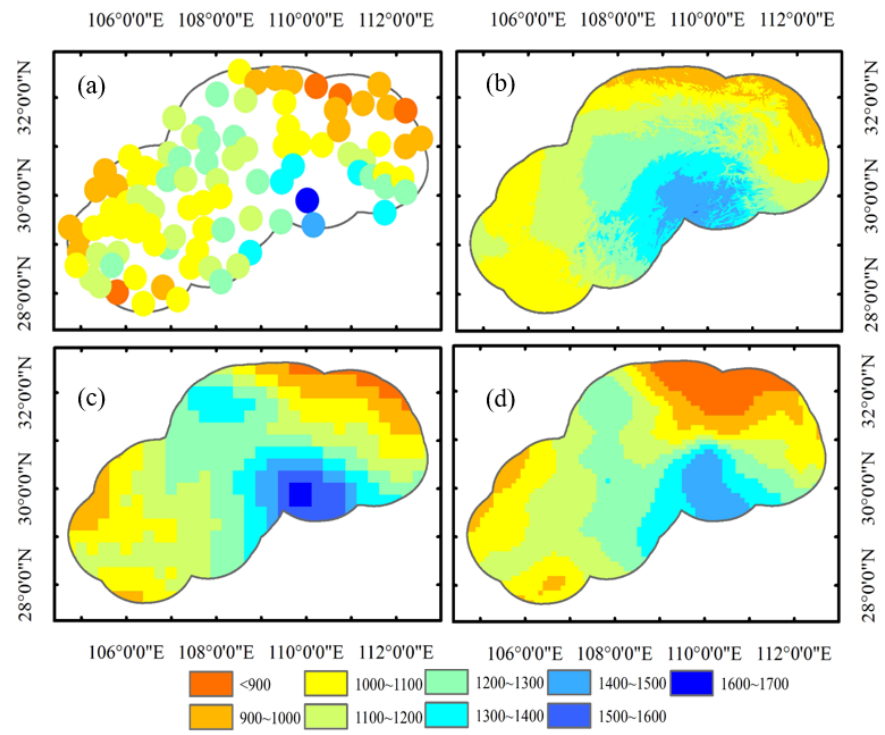
Figure A2. Spatial distribution of annual mean precipitation over 1988–2017 from ( a ) station obser- vations, ( b ) Peng et al. (2019) dataset, ( c ) CN05.1, and ( d ) CMFD (unit: mm/yr). In addition, we also used the three-cornered hat (TCH) method to evaluate the three datasets. Compared with the traditional error estimation methods, the TCH method can evaluate the accuracy of three or more different datasets when the true reference field is unknown [55,56]. In addition, this method is insensitive to the systematic biases and error cross-correlations contained within the datasets. The TCH method can be used to evaluate the uncertainty of multiple precipitation products in an iterative optimization process [57]. The RMSE values of CN05.1, CMFD and 1-km monthly precipitation dataset for China were obtained by the TCH method in the TGRA, which are 6.87 mm/month, 11.80 mm/month and 16.58 mm/month, respectively. CN05.1 has the lowest uncertainty in the TGRA, and the second lowest uncertainty is the CMFD, which adequately demonstrates the reliability of the CN05.1 dataset. Moreover, the TCH method is consistent with the evaluation method using station observations, and both show that CN05.1 has high accu- racy in the TGRA.